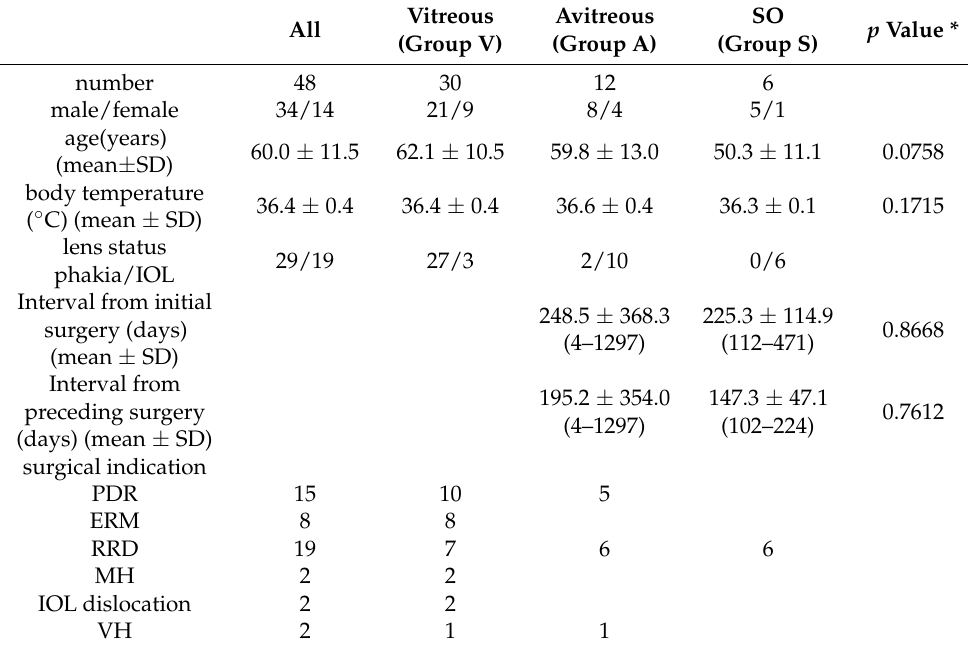
Table 1. Clinical characteristics in each